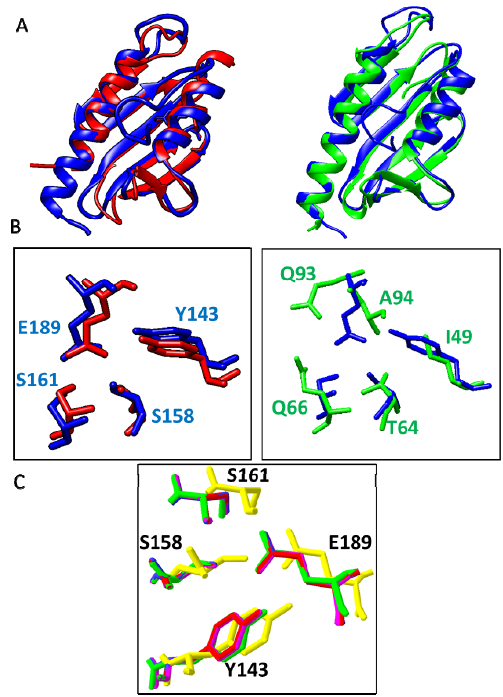
Figure 4. Comparison of the 3D structures of human frataxin (blue, PDB ID:3S4M) with those of S. cerevisiae frataxin (red, PDB ID:3OER), and E. coli CyaY (green, PDB ID:2EFF). ( A ) Superposed representation of the indicated structures. ( B ) Amino acids forming cluster 3 in the superposed structures from human (blue) and S. cerevisiae (red) frataxins (left panel), and in those from human frataxin (blue) and E. coli CyaY (green), right panel. ( C ) Cluster 3 in structural models for CyaY from R. tiphi (blue), R. akari (mauve), R. prowazekii (red), and R. bellii (yellow). Residues from human frataxin are shown in green and its sequence position